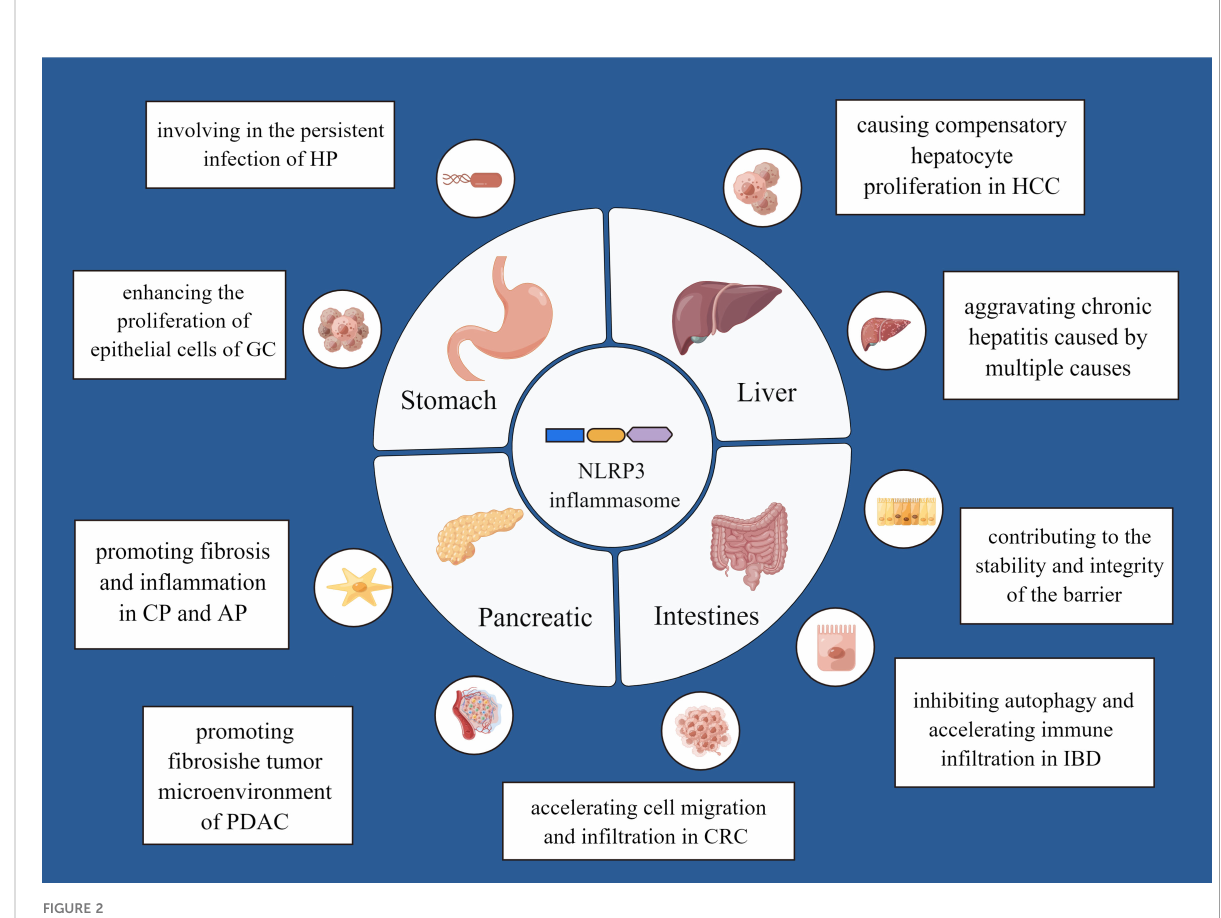
FIGURE 2 The mechanism of the NLRP3 in fl ammasome in various digestive diseases. By